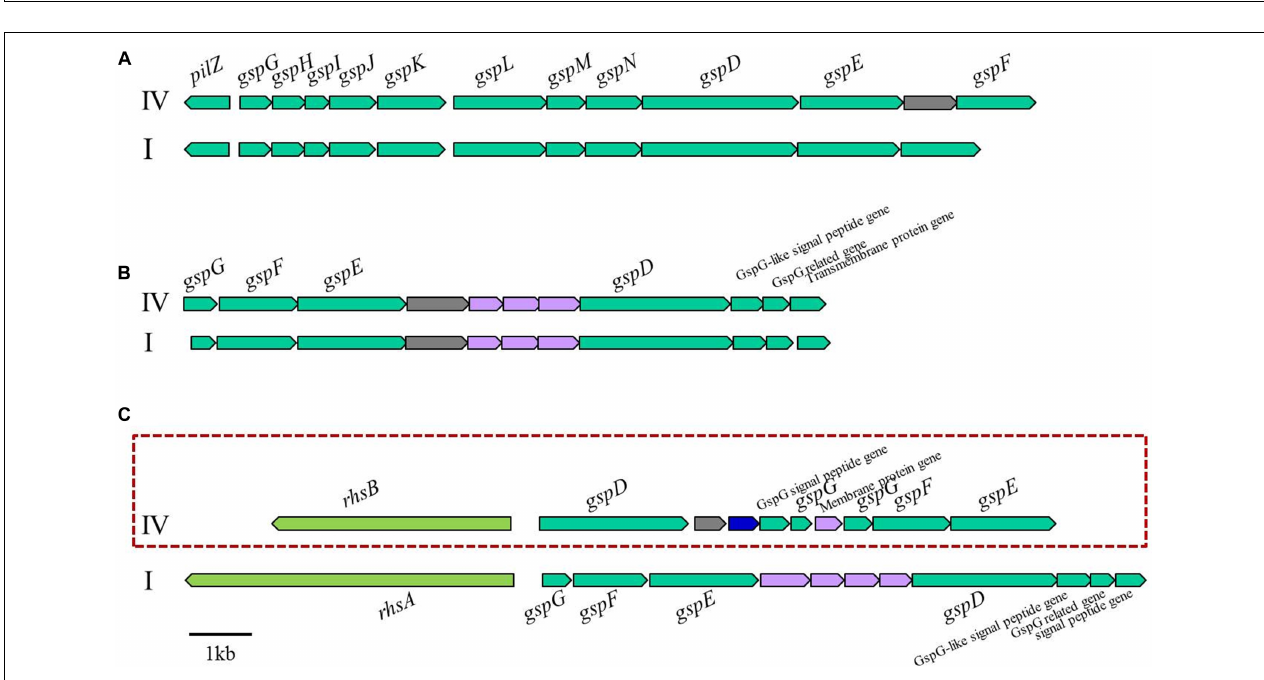
FIGURE 6 | Genetic organization of three T2SS gene clusters in phylotype IV and I strains of RSSC (A) orthodox T2SS cluster, (B) and (C) unorthodox T2SS cluster. IV, phylotype IV; I, phylotype I. The T2SS gene cluster in the red box did not exist in the strains of tomato non-pathogens (SL2312, T12, T82, and T101).